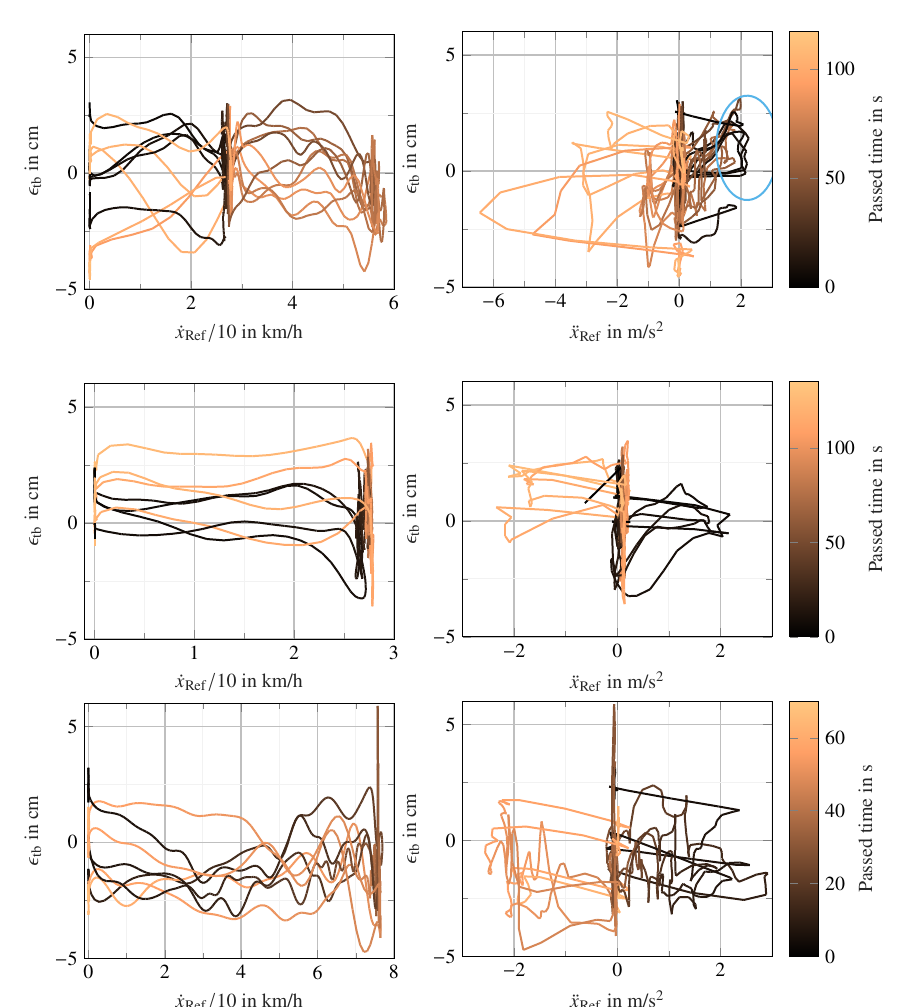
Figure 10. In the left column, (cid:101) tb vs. velocity is shown for the different velocity profiles mentioned in Section 4.2.4. During areas of “constant” speed, the distance error settles within the accuracy of the measurement devices. In the right column, (cid:101) tb vs. acceleration is shown. The distance error dynamics show only low sensitivity to acceleration. All trials are depicted and running time is denoted by the line’s color